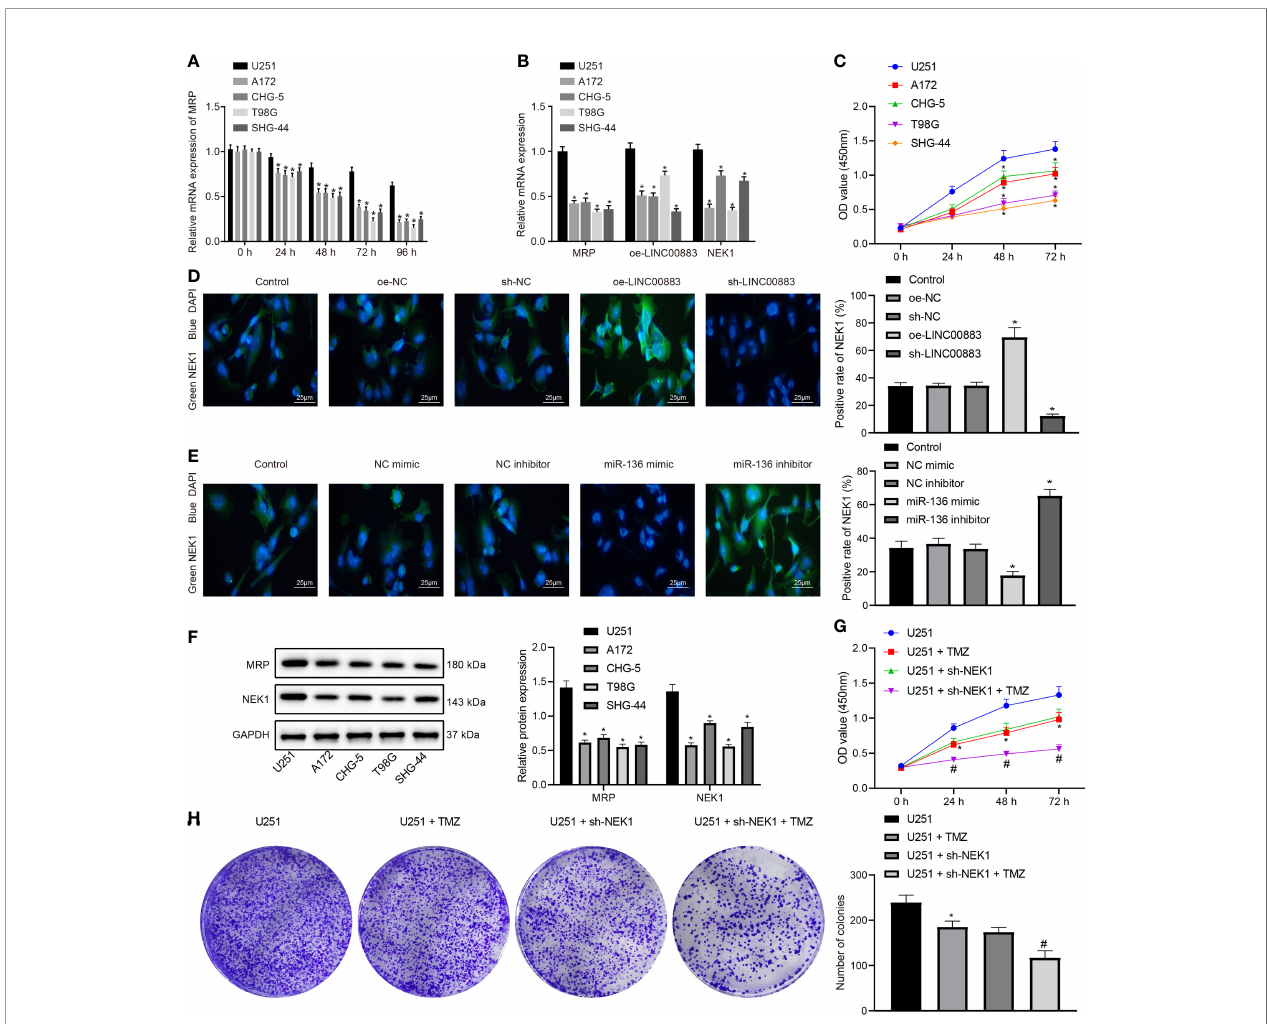
FIGURE 2 | Silencing of NIMA-related kinase 1 (NEK1) blunts the resistance of U251 cells to temozolomide (TMZ) and their proliferation. (A) The expression of multidrug resistance-associated protein (MRP) in fi ve glioma cell lines after treatment with TMZ (50 µM) at 0, 24, 48, 72, and 96 h as examined by RT-qPCR; * p < 0.05 vs. the U251 cell line. (B) The expression of MRP, LINC00883, and NEK1 in each cell line after treatment with TMZ (50 µM) at 72 h as detected by RT-qPCR; * p < 0.05 vs . the U251 cell line. (C) The viability of fi ve glioma cell lines after treatment with TMZ (50 µM) at 0, 24, 48, 72, and 96 h as examined by 3-(4,5-dimethylthiazol-2-yl)-2,5- diphenyltetrazolium bromide (MTT) assay; * p < 0.05 vs . the U251 cell line. (D) The NEK1 expression in U251 cell line after ectopic expression and depletion of LINC00883 as detected by immuno fl uorescence (×400); * p < 0.05 vs . the oe-NC/sh-NC group. (E) The NEK1 expression in U251 cell line after upregulation and depletion of miR-136 as detected by immuno fl uorescence (×400); * p < 0.05 vs . the oe-NC/sh-NC group. (F) The expression of MRP and NEK1 proteins in glioma cell lines following treatment with TMZ (50 µM) for 72 h as examined by Western blot analysis. * p < 0.05 vs . the U251 cell line. (G) The viability of U251 cells upon NEK1 knockdown after treatment with TMZ (50 µM) at 0, 24, 48, 72, and 96 h as examined by MTT; * p < 0.05 vs . the U251 cell line; * p < 0.05 vs . the U251 group; # p < 0.05 vs . the U251 + sh-NEK1 group. (H) Colony formation of U251 cells upon NEK1 knockdown after treatment with TMZ (50 µM) for 72 h as examined by colony formation assay; * p < 0.05 vs . the U251 group; # p < 0.05 vs . the U251 + sh-NEK1 group. The results were measurement data, which were expressed as mean ± standard deviation and analyzed by one-way analysis of variance. Biological and technical experimental replicates were performed in